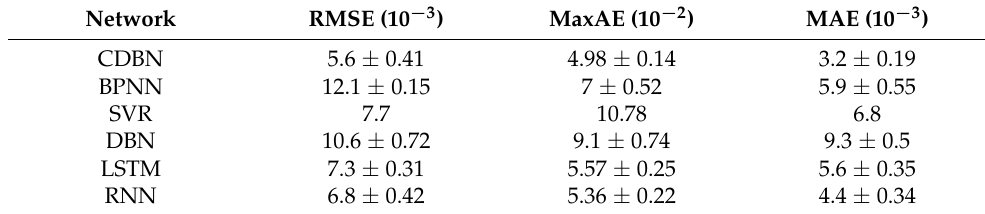
Table 7. Performance evaluation under four